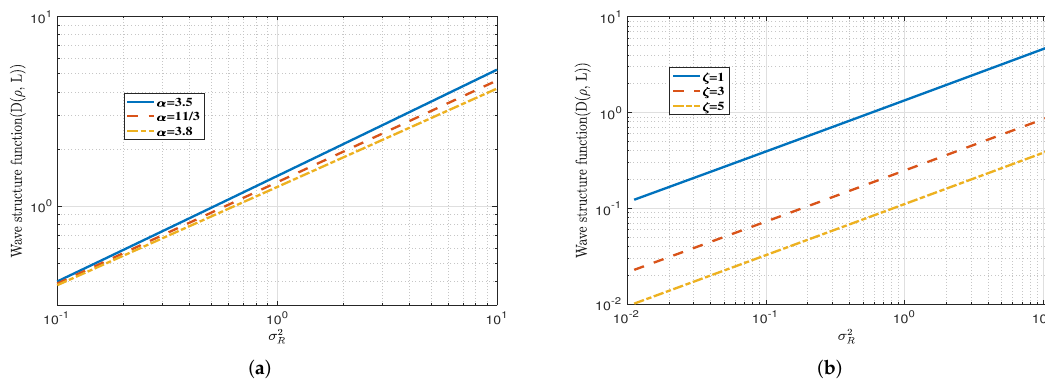
Figure 2. WSF of a collimated beam as a function of increasing turbulence σ 2 exponent α and ( b ) anisotropic parameter ζ